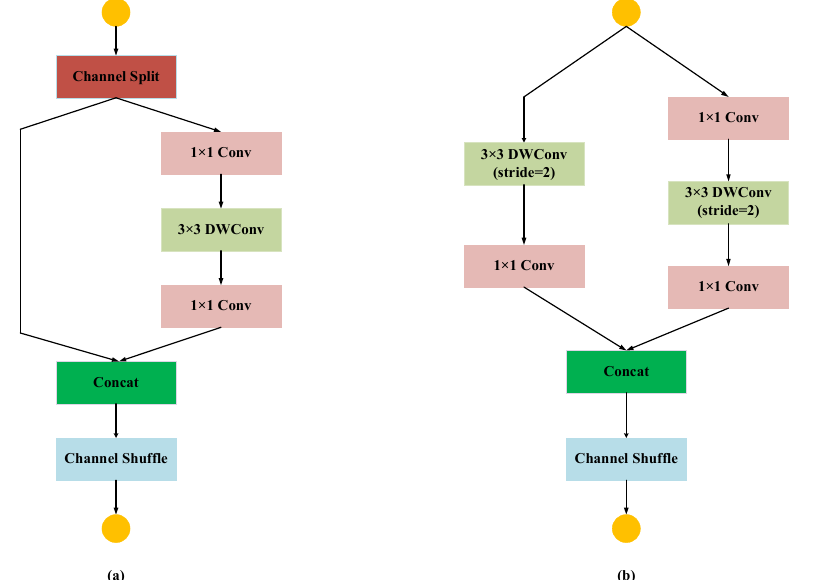
Figure 4. ( a ) ShuffleNet V2 Unit1 ( b ) ShuffleNet V2 Unit2. ShuffleNet-V2 is an effective lightweight deep-learning network with only 2M parameters. It uses the idea of group convolution from AlexNet and channel shuffle, which not only greatly reduce the number of model parameters, but also improve the robustness of the model. (DWConv [20]: Depth Wise Convolution).